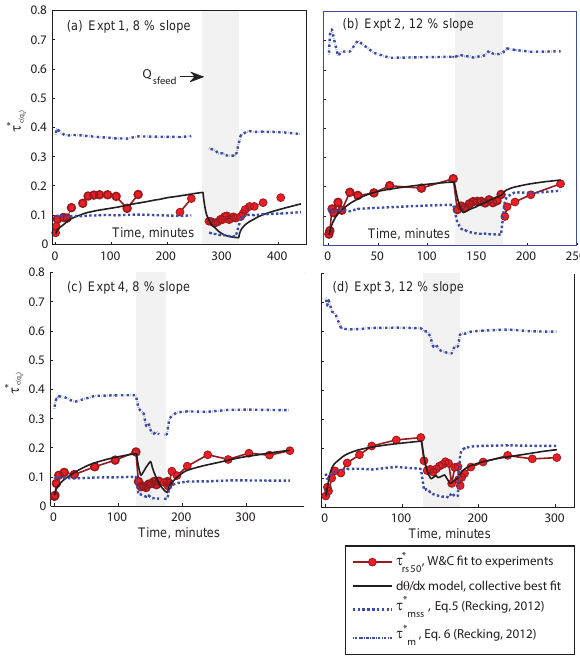
c( q s ) Figure 10. Comparison of experimental and best-fit model con- straints on τ ∗ , compared to proposed constraints for D 84 refer- rs50 ence stress bounds for low and high sediment supply from Reck- ing